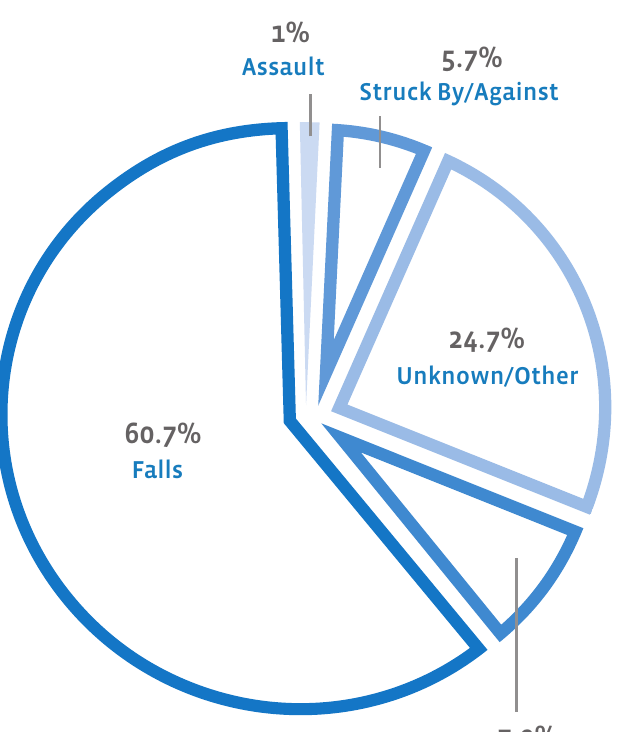
FIGURE 6: Estimated Average Percentage of Annual Traumatic Brain Injury-Combined Emergency Department Visits, Hospitalizations, and Deaths Among Children 0 to 14 Years, by External Cause, United States, 2002–2006